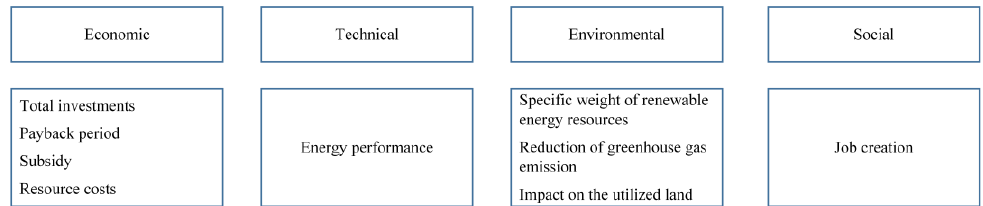
Fig. 2. Indicators for Renewable Energy Heating